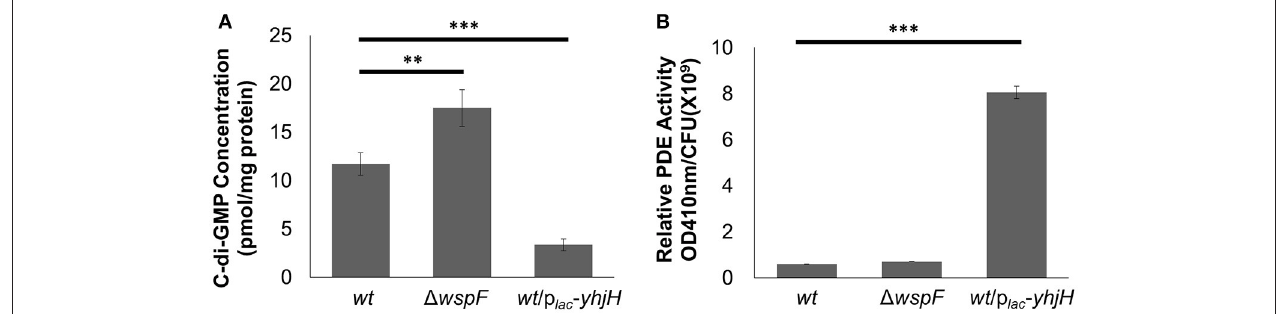
FIGURE 1 | Higher PDE activity in P. aeruginosa /p lac -yhjH correlated to lower c-di-GMP levels. (A) C-di-GMP quantification by LCMS in P. aeruginosa wt , 1 wspF and P. aeruginosa /p